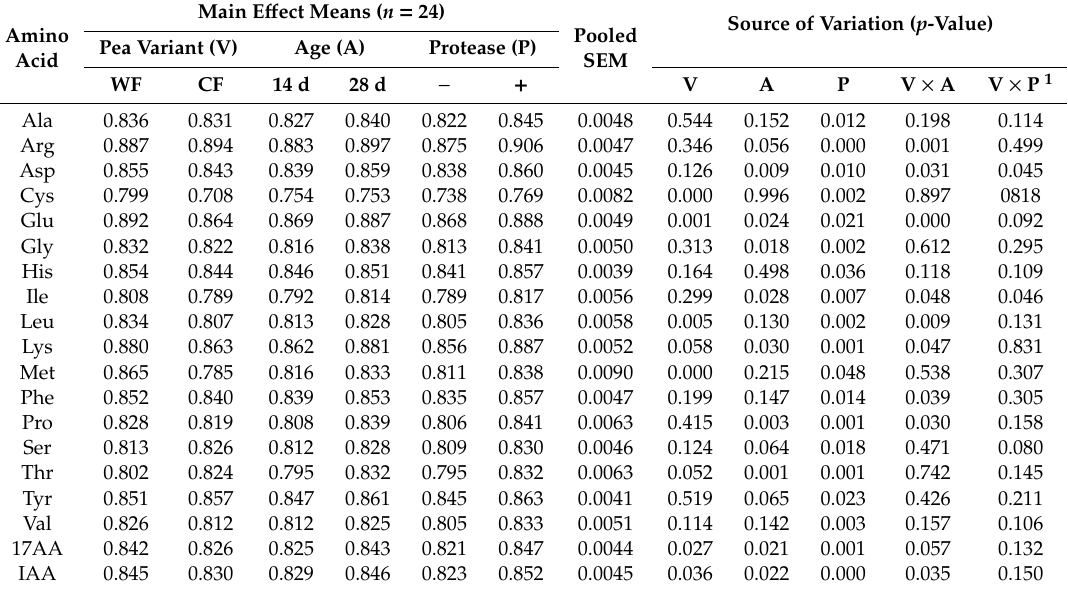
Table 4. Flower colour variant, age of broiler chickens and protease addition main e ff ects on the standardised ileal amino acid digestibility of test pea seeds. Amino